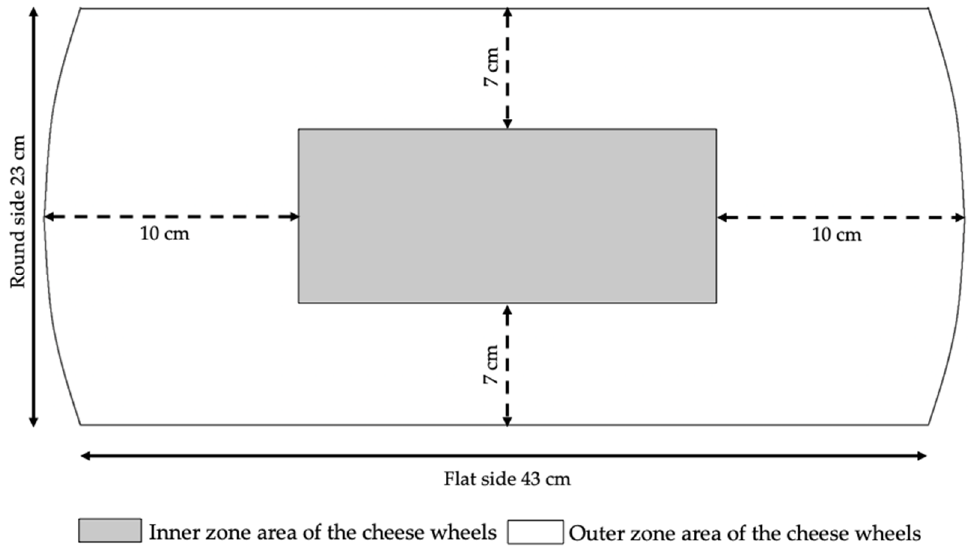
Figure 1. Scheme of sampling from a vertical section of a Parmigiano Reggiano cheese